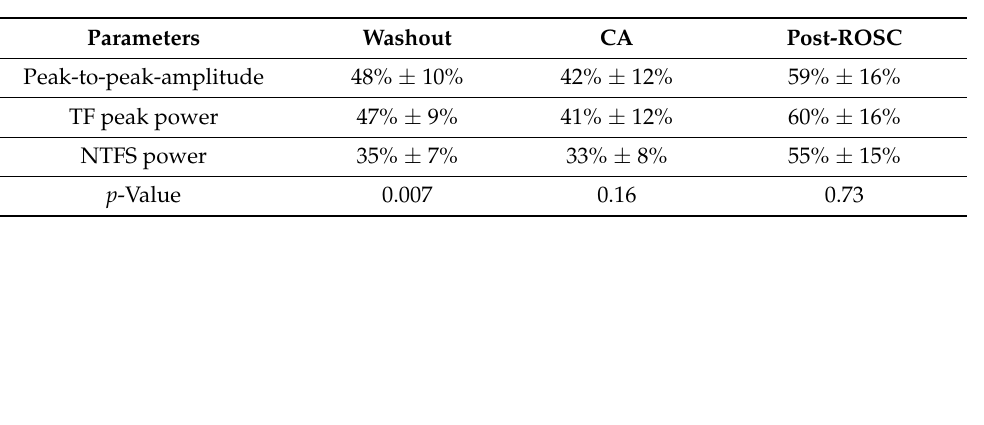
Table 2. Within-subject coefficients of variations ( CV s) of single-trial time and TF parameters of HFOs (mean ± SD).